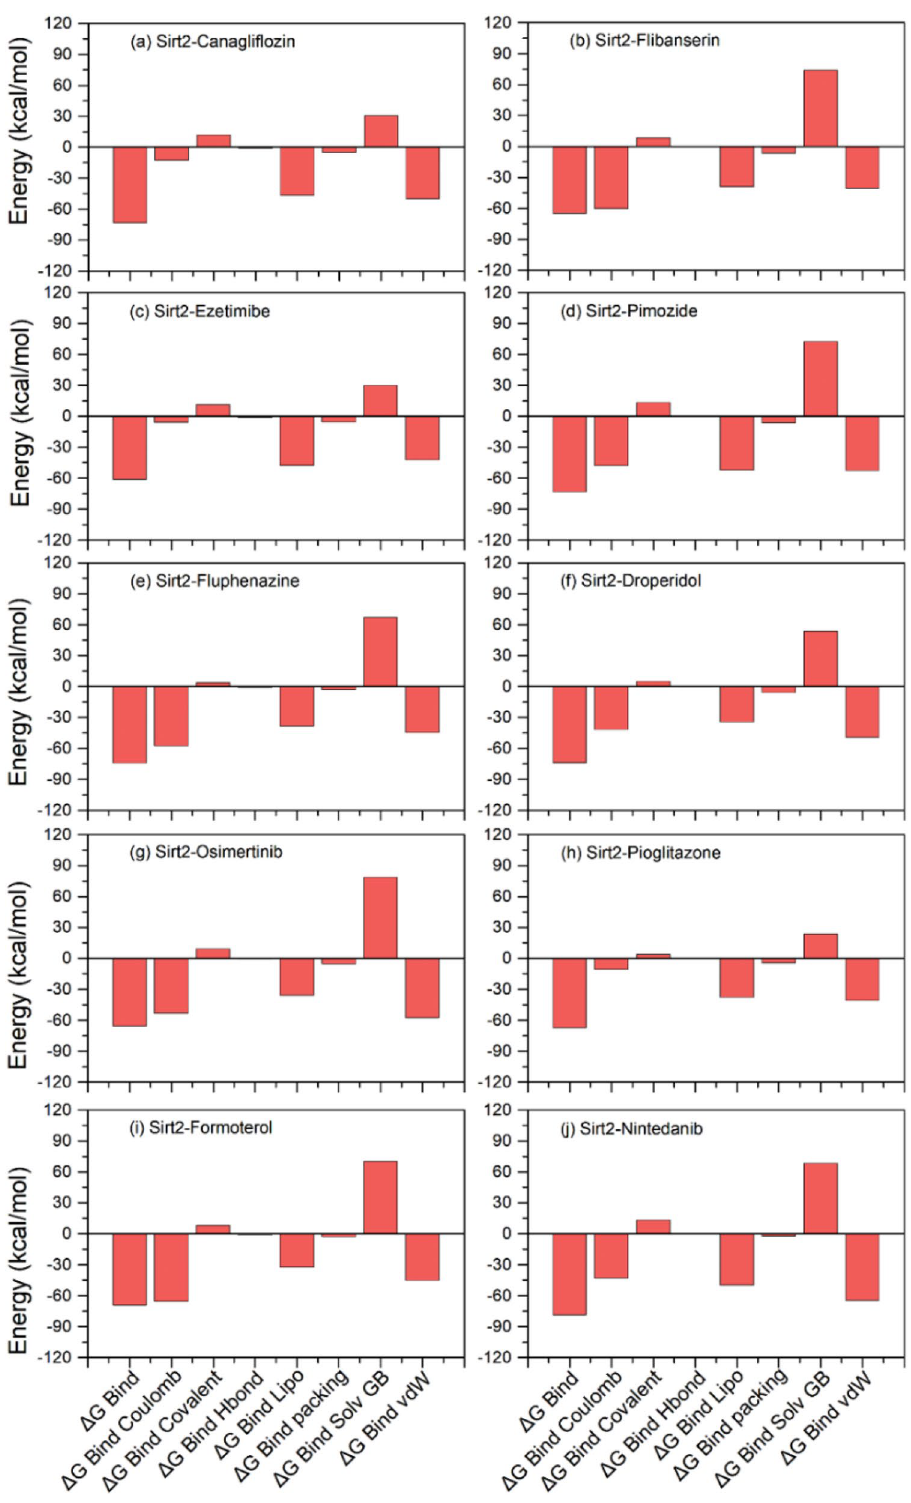
Figure 4. Estimation of binding free energy and individual dissociation energy components calculated for the docked complexes of FDA-approved drugs with Sirt2 using MM/GBSA